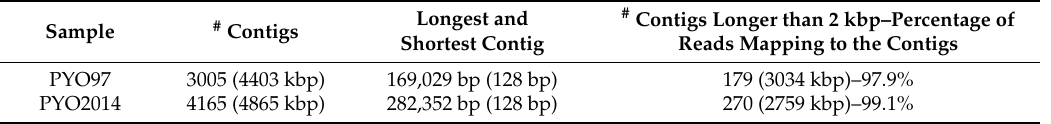
Table 2. Summary of the assembly results.